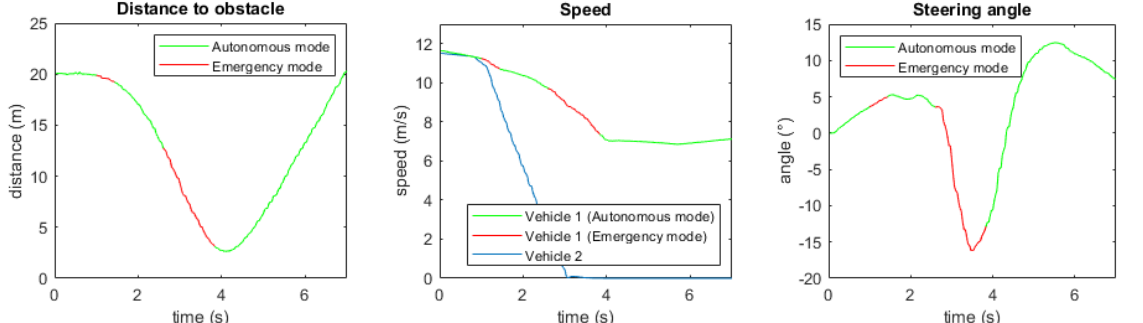
Figure 22. Parameters of ego vehicle in second scenario: distance to obstacle ( left ), speed ( middle ) and steering angle ( right